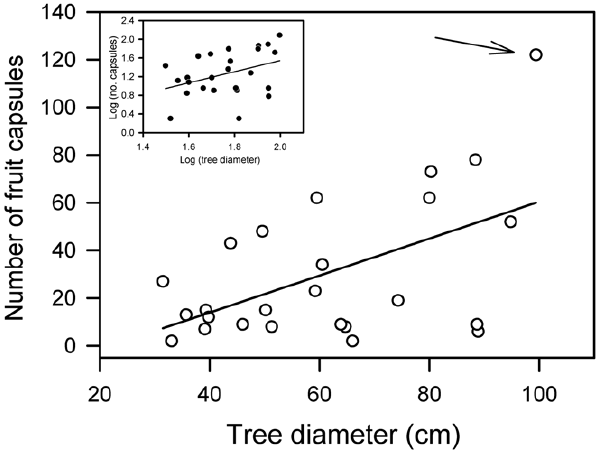
Figure 1. Fruit production as a function of stem diameter for 25 mahogany ( Swieteniamacrophylla ) trees in 2005 in Para´, Brazil. One fruit capsule contains on average 40–42 viable seeds. The regression line was significant (adj. r 2 =0.26, P =0.0058, y =–17.1 + 0.775 x ) but lacked constant variance. The arrow points to a heavy fruiter outside 95% confidence intervals; its removal from the analysis resulted in a marginally significant relationship between tree diam and fruit production (adj. r 2 =0.13, P =0.047). The inset shows the same 25 trees with diam and reproductive output log-transformed to stabilise the variance (adj. r 2 =0.14, P